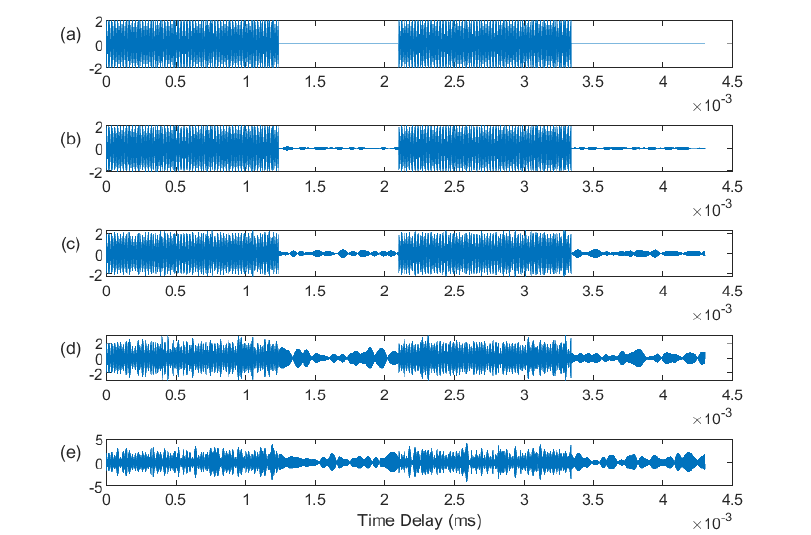
Figure 4. The echo signals of proposed method under different inband SNR: ( a ) Pure echo signal; ( b ) echo signal at SNR = 25 dB; ( c ) echo signal at SNR = 15 dB; ( d ) echo signal at SNR = 5 dB; and ( e ) echo signal at SNR = 0